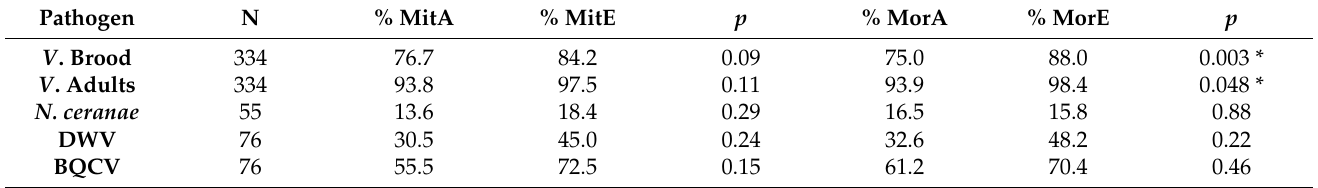
Table 1. Prevalence of four pathogens detected in honey bee colonies of African or European mitotype (% MitA and % MitE, respectively) and of African or European morphotype (% MorA and % MorE, respectively). Data shown includes % colonies infested by Varroa destructor in brood ( V . Brood) and adults ( V . Adults), % colonies infected by Nosema ceranae ( N. ceranae ) and % colonies infected by deformed wing virus (DWV) and black queen cell virus (BQCV).